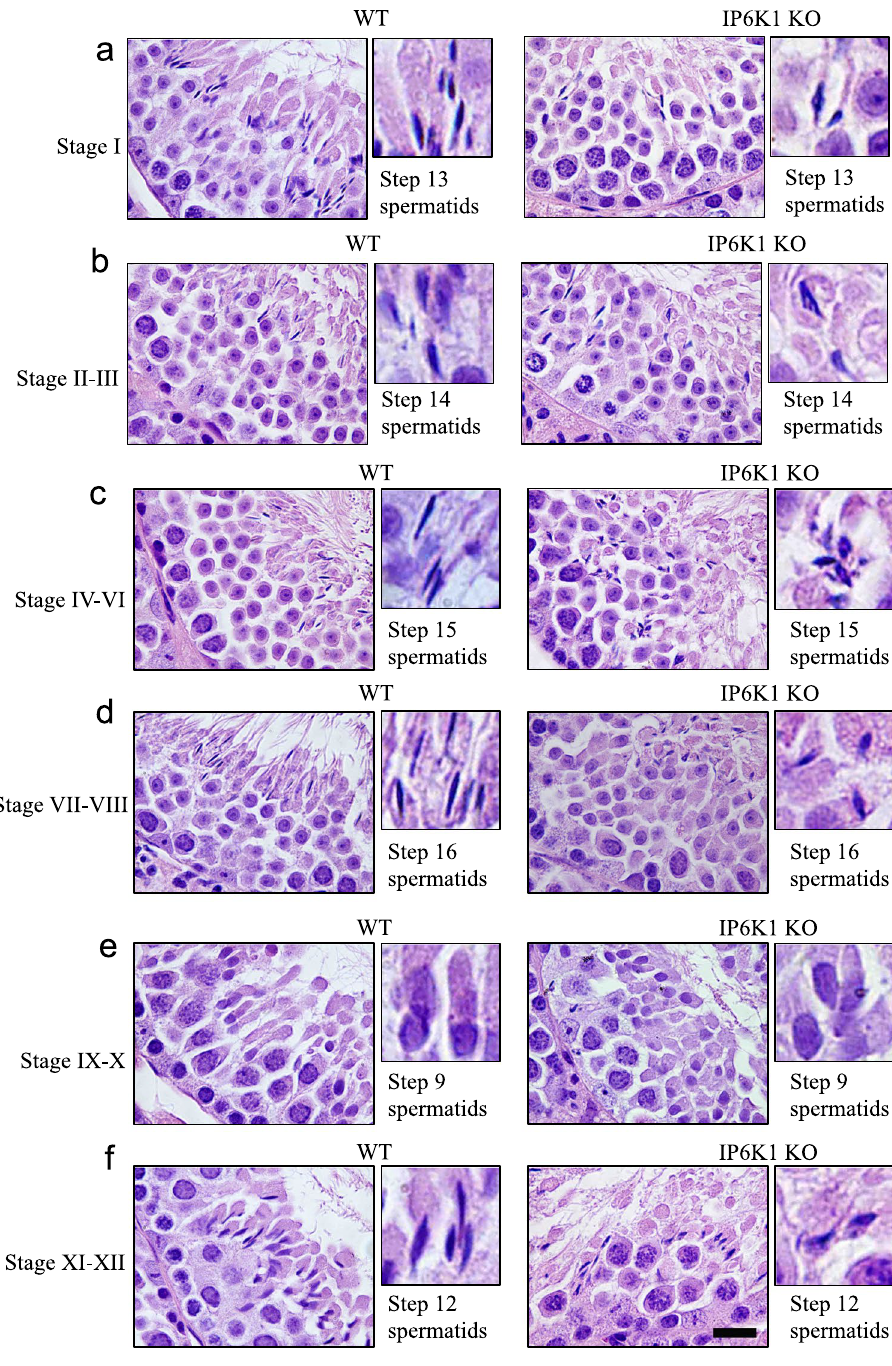
Figure 3. Deletion of IP6K1 elicited disorientation and malformation of elongating/elongated spermatids. ( a – f ) H&E staining of WT and IP6K1 KO testes. Stages of seminiferous tubules were determined by spermatid developmental status. ( a , b , c , d , f ) Cell polarity and morphology of the step 12–16 elongating/elongated spermatids were disrupted in IP6K1 KOs (insets). Scale bar 20 μ